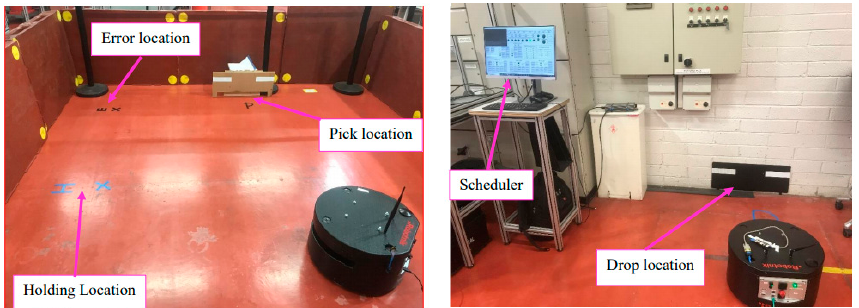
Figure 19. Testing setup. Here, the coordinates of single pickup location are used for two pickup locations and similarly scheduler is tested for three drop ‐ off locations by using coordinates of single drop ‐ off location.